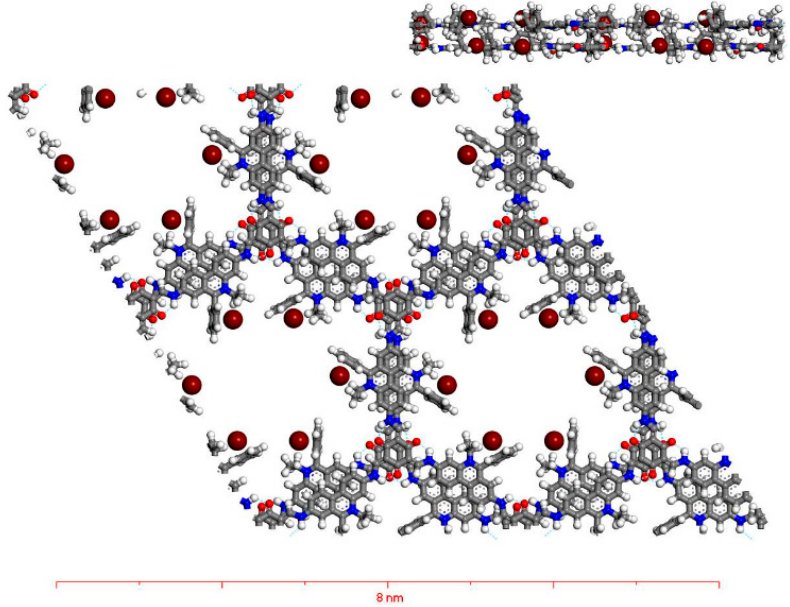
Figure 3. Top view of simulated Br-COF structure, inset: side view of offset ABA staking of Br-COF layers.